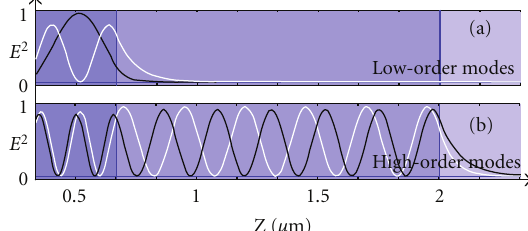
Figure 7: The vertical mode profiles of the ordinary OLEDs struc- tures. (a) low-order modes (b) high-order